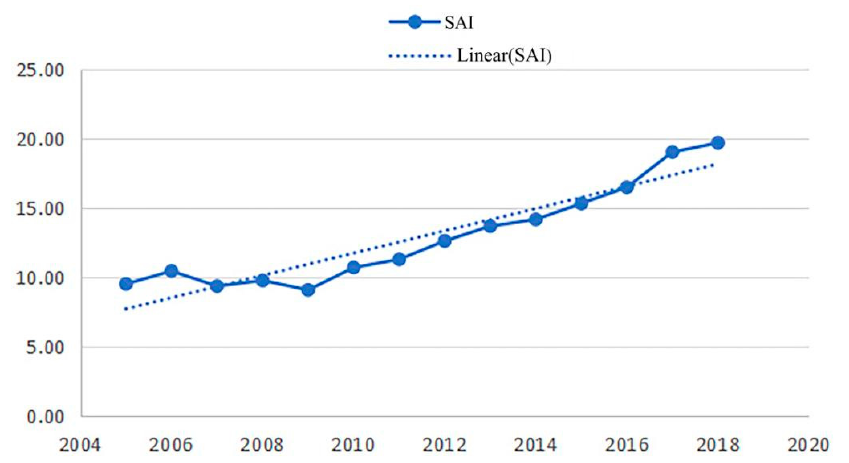
Figure 3. Xinjiang cotton production scale advantage (SAI).